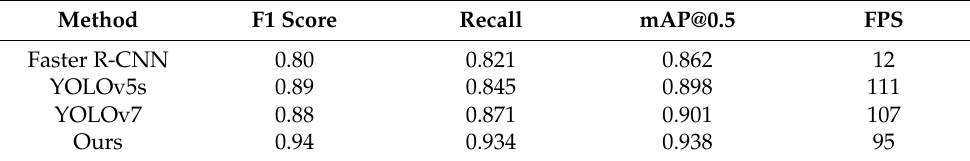
Table 9. Comparison of evaluation indicators of different